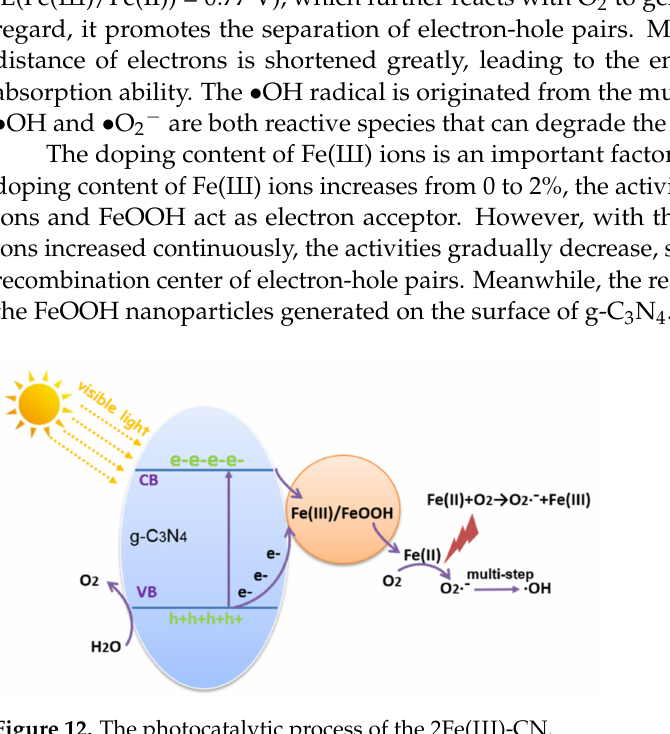
Figure 12. The photocatalytic process of the 2Fe( Ш